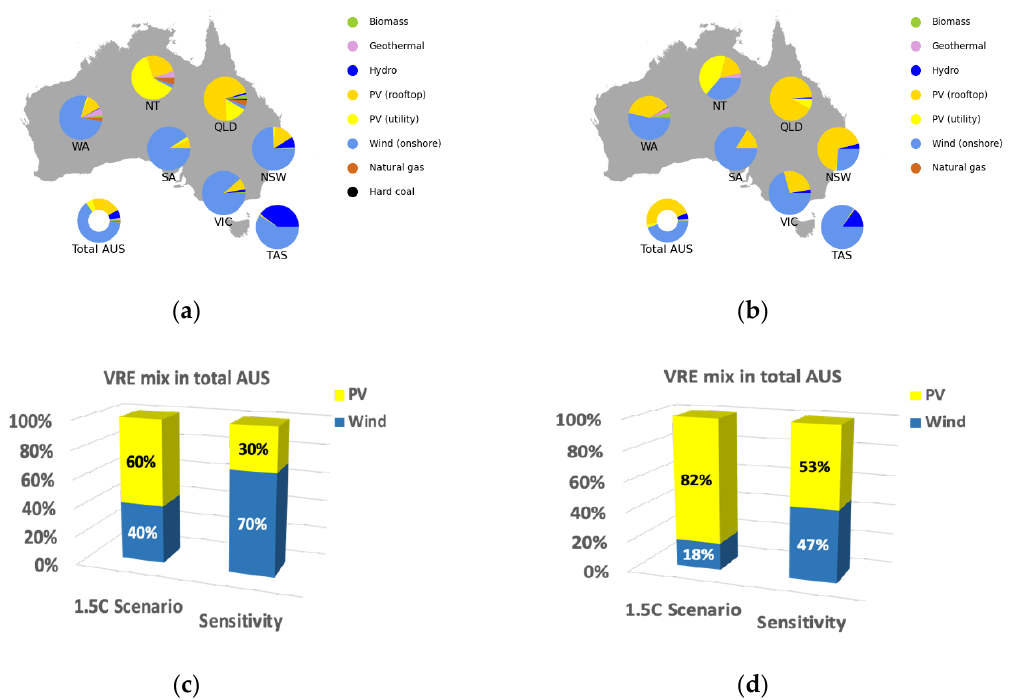
Figure 4. Sensitivity case P1.5 °C-PVStoCost-High: ( a ) regional distribution of power production mix in 2030; ( b ) regional distribution of power production mix in 2050; ( c ) Variable Renewable Energy (VRE) mix in sensitivity case versus P1.5 °C scenario in 2030; ( d ) VRE mix in sensitivity case versus P1.5 °C scenario in 2050.